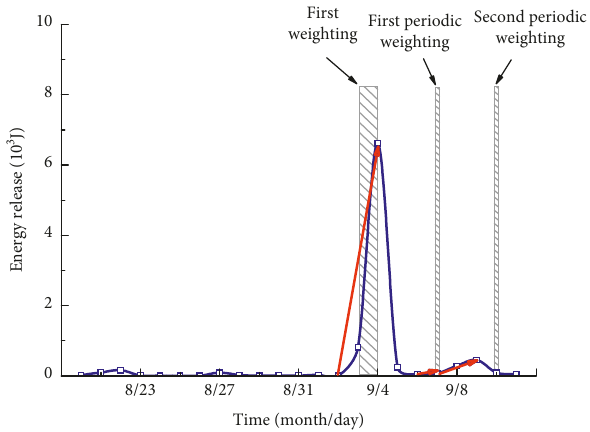
Figure 11: Changes of energy release with time.